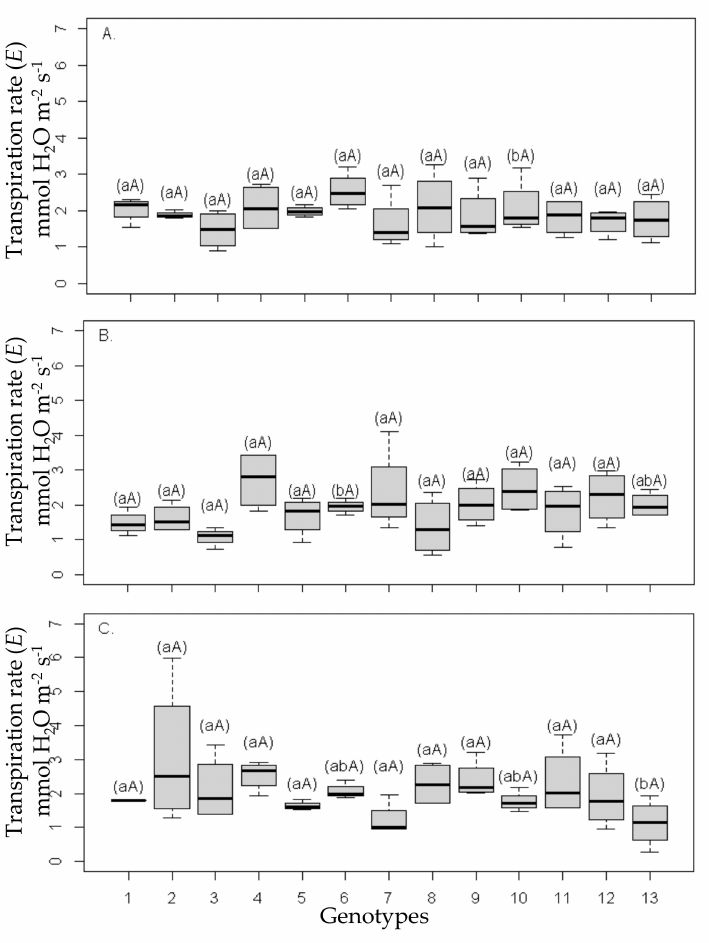
Figure 15. Boxplot relative to the average transpiration rate ( E ) of 13 citrus rootstocks in combination with ‘Tahiti’ acid lime ( Citrus × latifolia (Yu. Tanaka) Tanaka) under irrigation with waters of 0.14 ( A ), 2.40 ( B ), and 4.80 dS m − 1 ( C ), in the second year. For identification of genotypes, see Table 1. Boxplots with the same lowercase letter do not differ statistically, according to the Tukey test between salinity levels ( p ≤ 0.05), and those with the same uppercase letter belong to the same genotype group, according to the Scott–Knott test ( p ≤